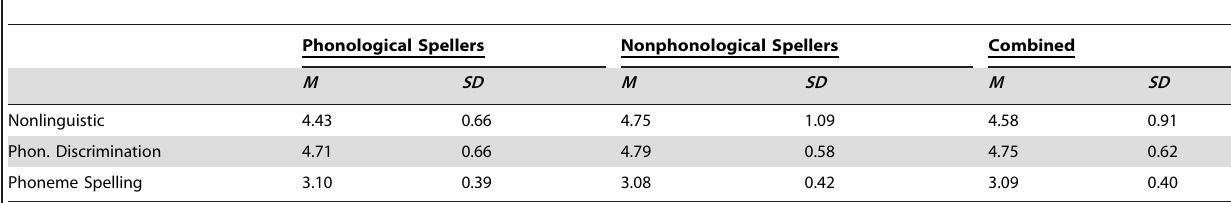
Table 2. Means and Standard Deviations for Reaction Time (in seconds) in Auditory Processing